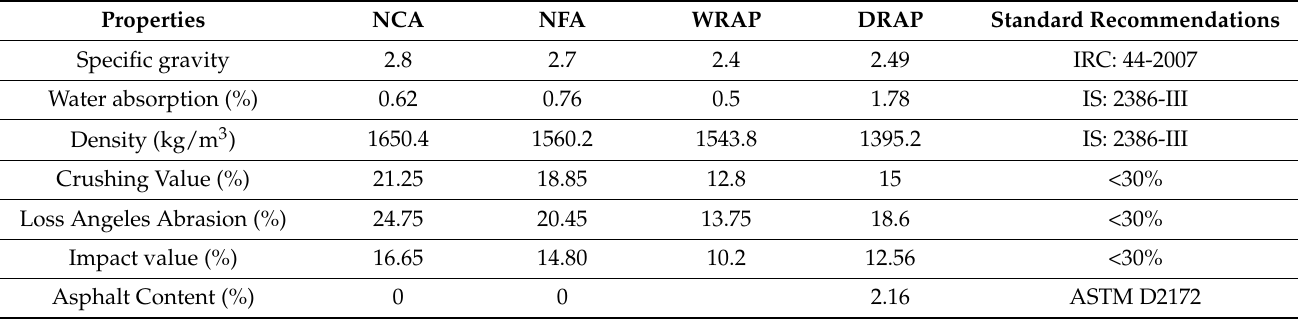
Table 1. Physical properties of RAP